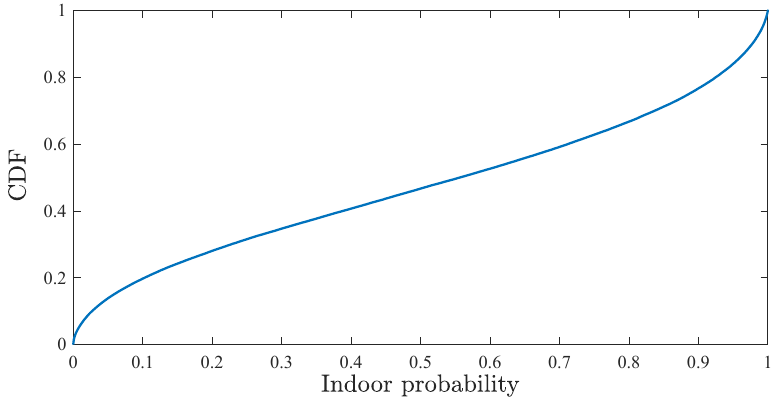
Figure 2. CDF of indoor connections probabilities, P indoor ( k ) , in the scenario. The land use map and the geolocated publication distribution map are defined as a grid, with 10 × 10 m 2 tiles for sufficient resolution. Table 2 shows a breakdown of the land use types, their description, indoor/outdoor classification and percentage of occupancy in the scenario. Table 2. Land use types in the